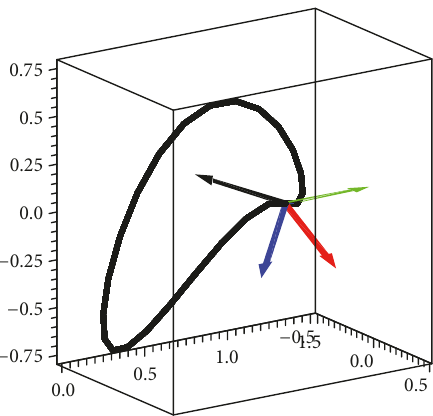
Figure 7: Red vector is 𝑇 (0) , blue vector is 𝑁 (0) , green vector is 𝐵 (0) , and black vector is 𝑉 .